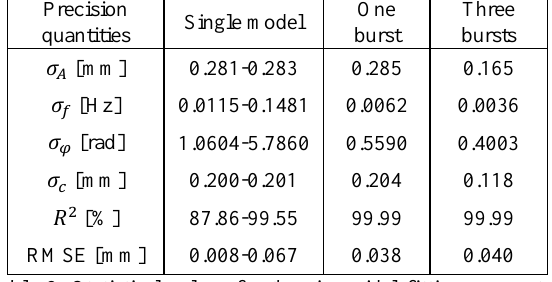
Table 3. Statistical values for the sinusoidal fitting parameters